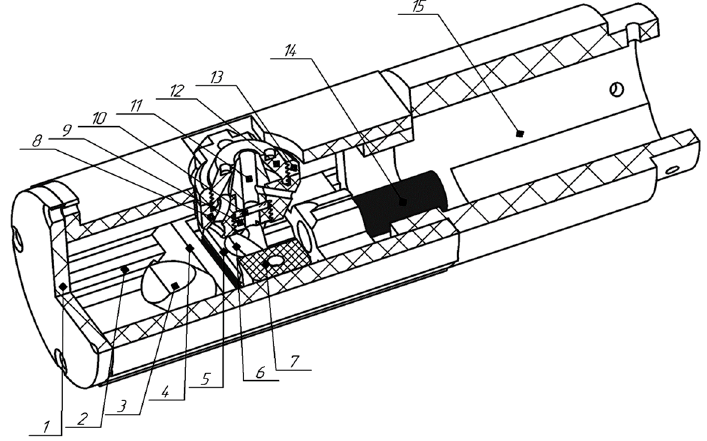
Figure 10. Developed laser spraying head: 1—end cap, 2—laser head housing, 3—tilt angle motor, 4—adjusting slider, 5—toothed hinge, 6—mirror, 7—hinge, 8—nozzle housing, 9—pressure hood,